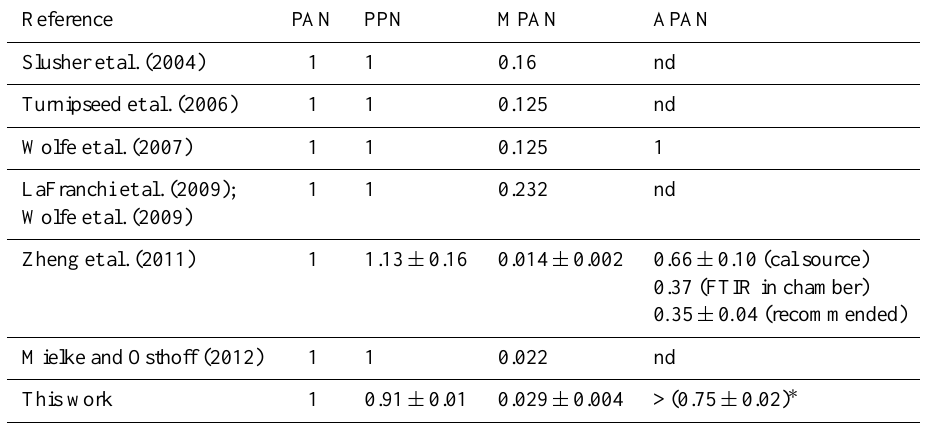
Table 9. Relative response factors of the TD-CIMS for PAN, PPN, MPAN and APAN in this work and recent literature values. “nd” means not determined or reported.